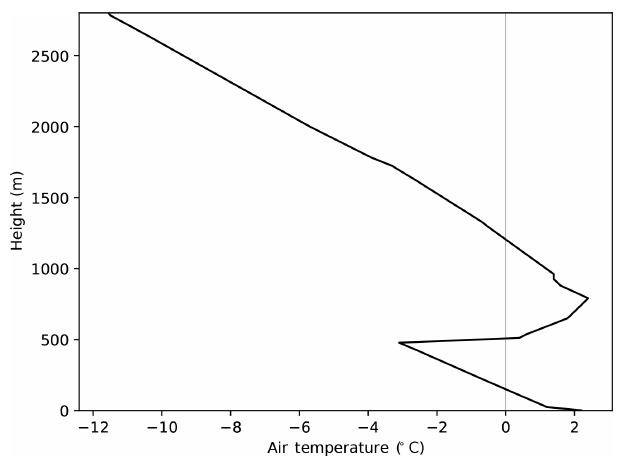
Figure 9. Radiosonde from Greifswald on 31 March 2018 at